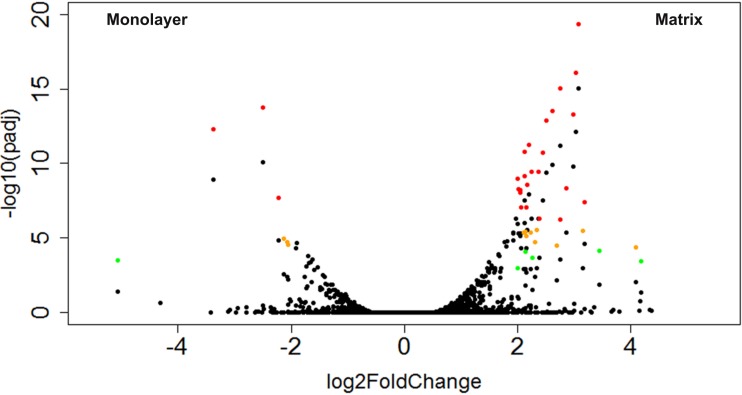
Volcano plot of CTSs that fulfilled expression threshold criteria.The log2 transformed fold change between monolayer and matrix environments is plotted against the negative log10 of the p value. The CTSs that were found to be significantly differentially expressed using our criteria of log2 fold change ≥ 2 and adjusted p values ≤ 0.1, 0.01, or 0.001 are shown in green, yellow, or red, respectively.